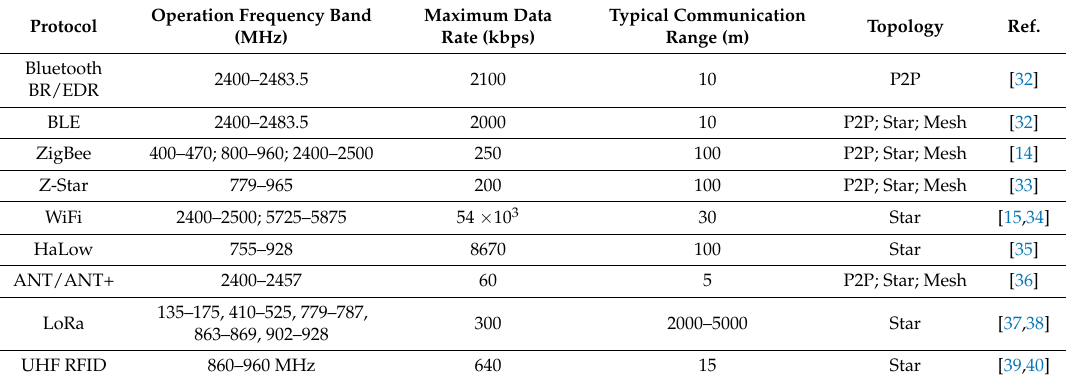
Table 2. Survey of potential Wireless Protocols for next generation Internet of